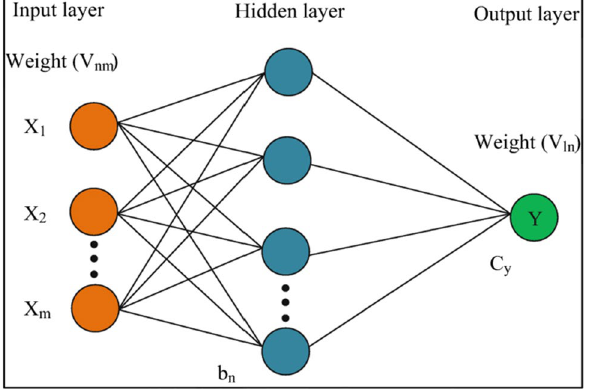
Fig. 4 Schematic of the ANFIS